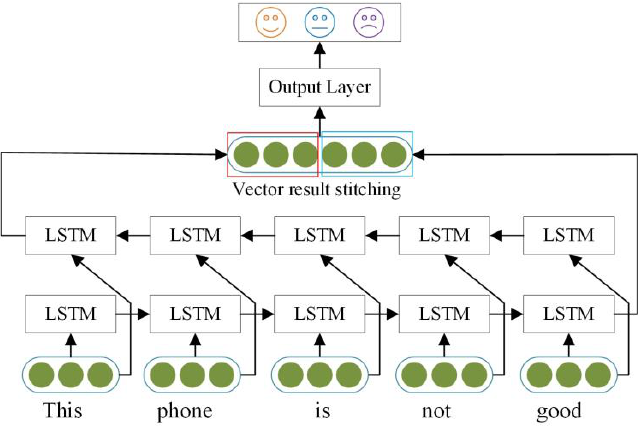
Figure 2. BiLSTM model structure.